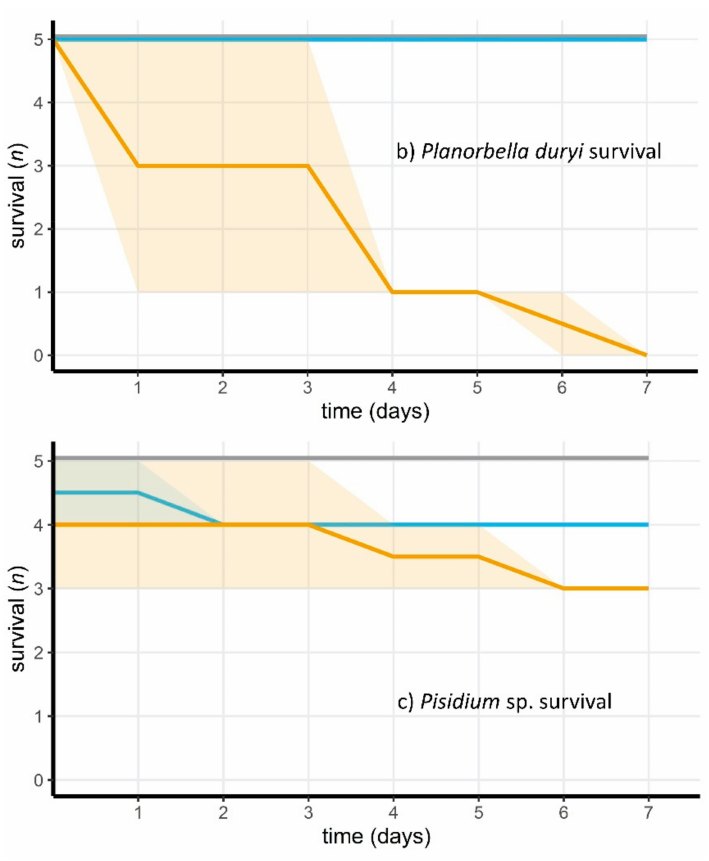
Figure 1. Survival of aquatic invertebrates (( a ) Asellus aquaticus , ( b ) Planorbella duryi and ( c ) Pisidium sp.) after exposure to Wofasteril40 concentrations of 2913 mg/L (blue) and 291.3 mg/L (orange). Shaded areas indicate uncertainties about survival due to inactivity of the respective mollusk species.